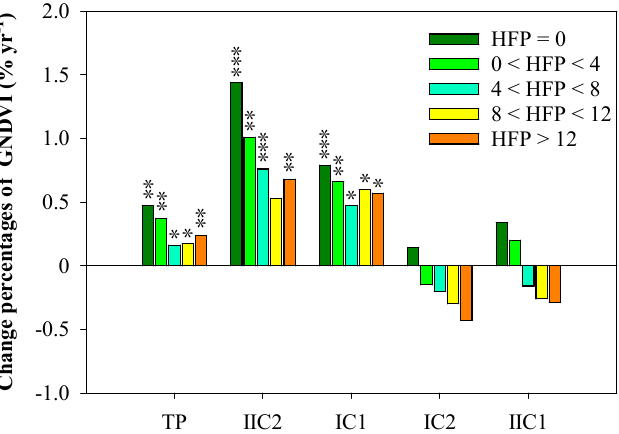
Figure 9. Differences in change percentage of growing season NDVI (GNDVI) versus human footprint pressure (HFP) from 2000 to 2015. *** p < 0.001; ** p < 0.01; * p < 0.05.